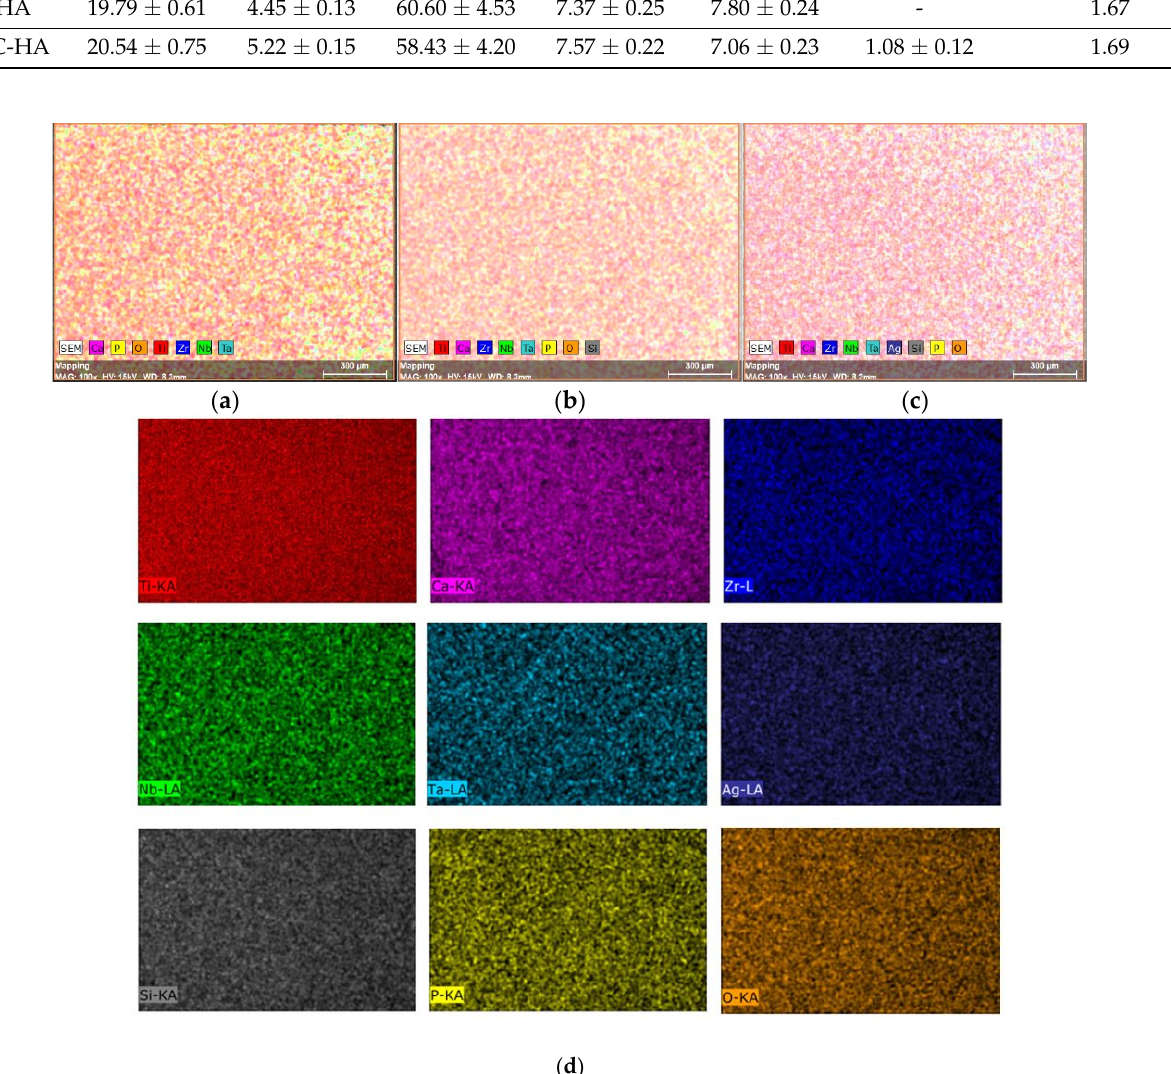
Table 3. The elemental composition of the Ti–10Nb–10Zr–5Ta alloy. Elemental Composition (at. %) Coating Ca Ag (Ca + Ag)/(P +